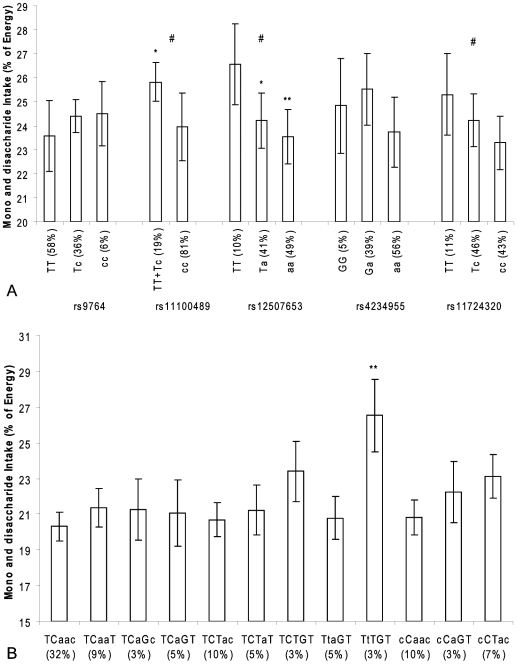

NPY1R/NPY5R variants and mono- and disaccharide intake in the Hamlet population.Figure 3a shows the association of SNPs in the NPY1R/NPY5R region with mono- and disaccharide intake as percentage of total energy intake. The ancestral alleles are indicated as capital letters.*p<0.05, **p<0.01(compared with linear regression model), # P<0.01 for trend. Figure 3b shows the association of NPY1R/NPY5R haplotypes with mono- and disaccharide intake as percentage of total energy intake. The haploblocks consist of the SNPs rs9764, rs11100489, rs12507653, rs4234955 and rs11724320 and the ancestral alleles are indicated as capital letters. *p<0.05 (compared with linear regression model).